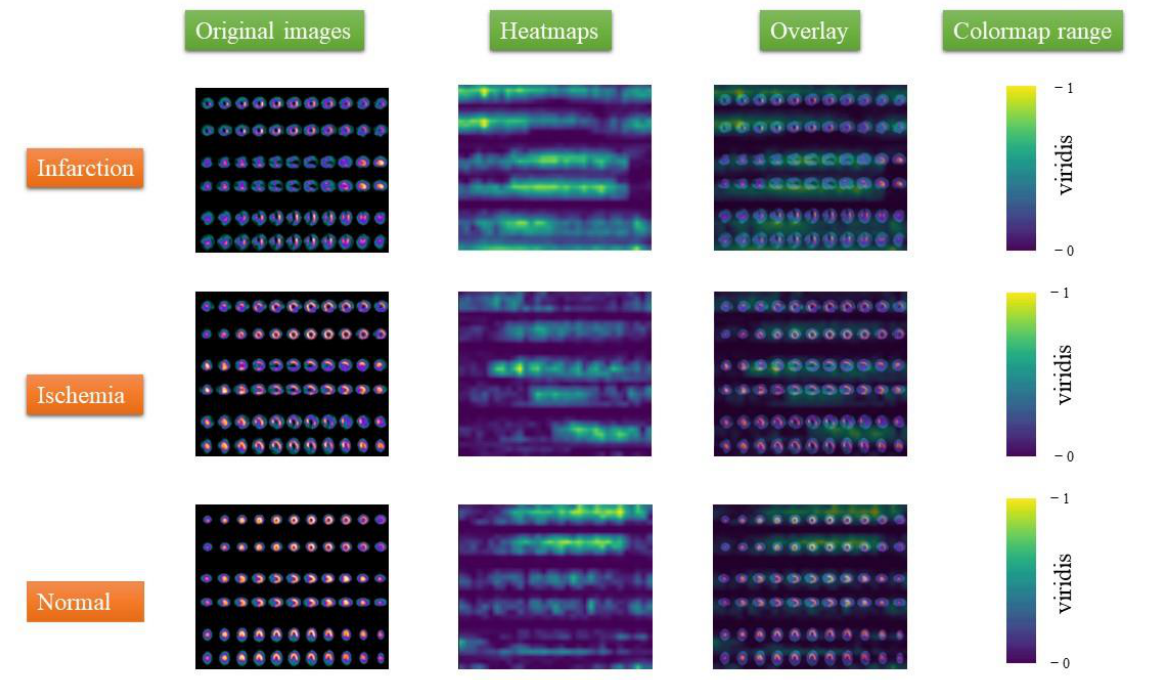
Figure 4. Visualized results generated by Grad-CAM.